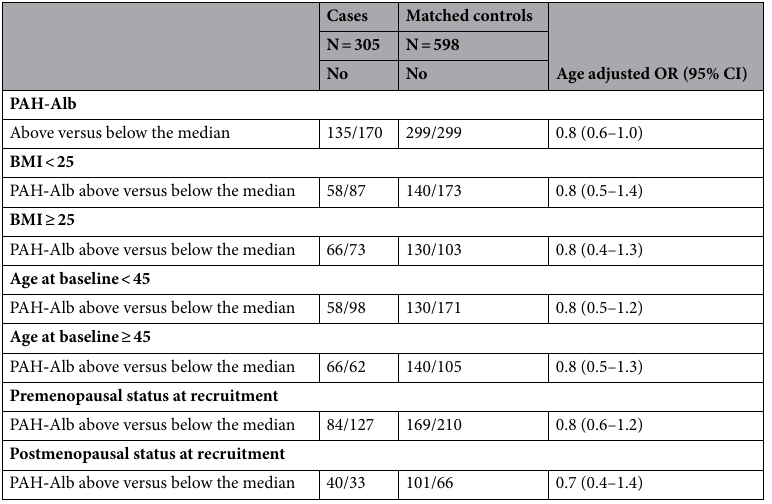
Table 2. The association of PAH-albumin adducts and breast cancer risk by selected risk factors, the cancer screening program cohort. Alb albumin, OR odds ratio, PAH polycyclic aromatic hydrocarbons.